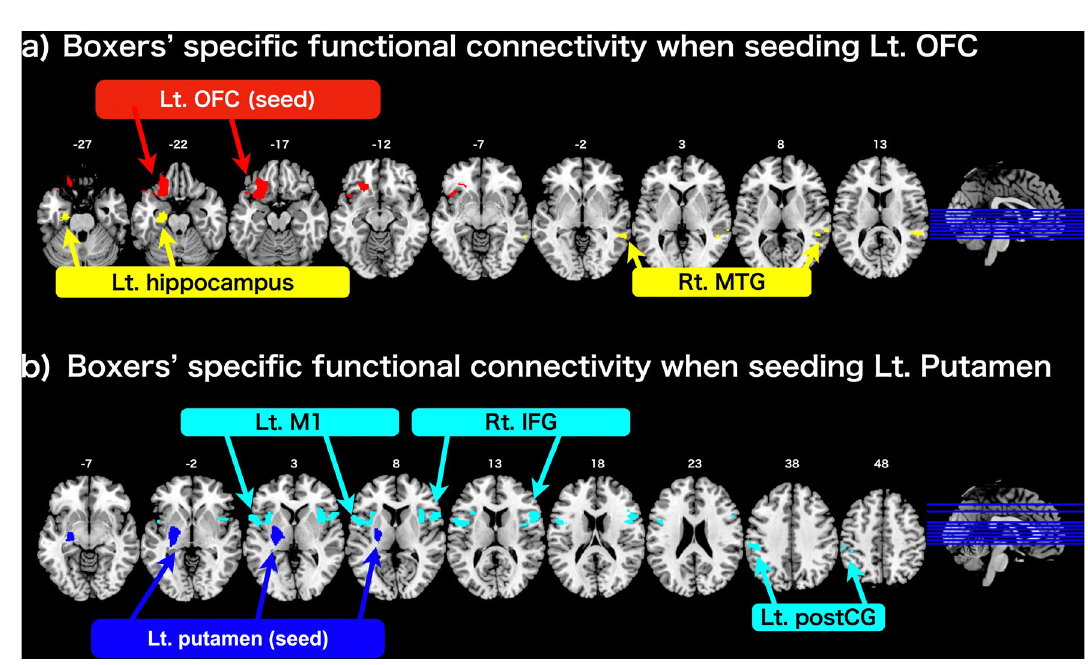
Figure 4. Boxers’ specific functional connectivity ([Boxers (Time1) > Controls]). ( a ) The statistical contrast between boxers and controls when seeding the left OFC (shown in red) delineated significant functional connectivity with the left hippocampus and the right MTG (shown in yellow colour respectively). ( b ) The statistical contrast between boxers and controls when seeding the left putamen (shown in blue) delineated significant functional connectivity with the left M1 cluster including the left premotor and anterior insular cortex, the left postCG, and Rt. IFG cluster including the right anterior insular cortex (shown in cyan colour respectively). The statistical threshold for significance was set at FWE-corrected p < 0.05 at the cluster level, with an uncorrected p < 0.001 at the voxel level. Lt, left; Rt, right; M1, primary motor cortex; MTG, middle temporal gyrus; postCG, postcentral gyrus; IFG, inferior frontal